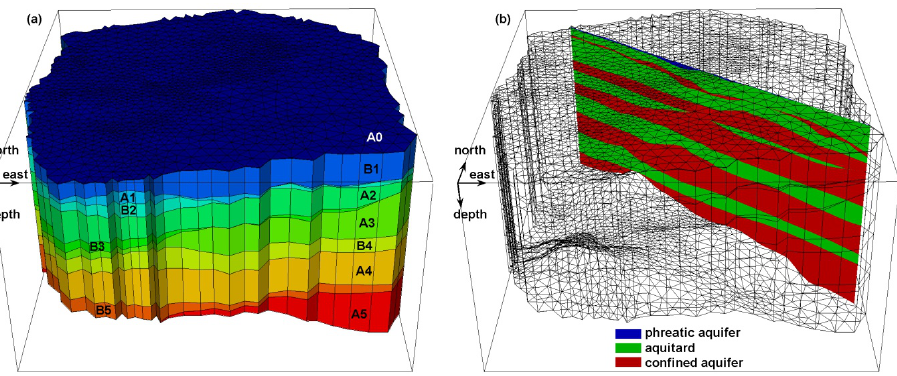
Figure 3. Perspective views of the 3-D finite-element mesh of the center area of Shanghai. The various geologic layers are distinguished in (a) . In (b) the hydro-stratigraphic units are highlighted on the center part of the vertical section passing along the I-I’ profile traced in Fig.